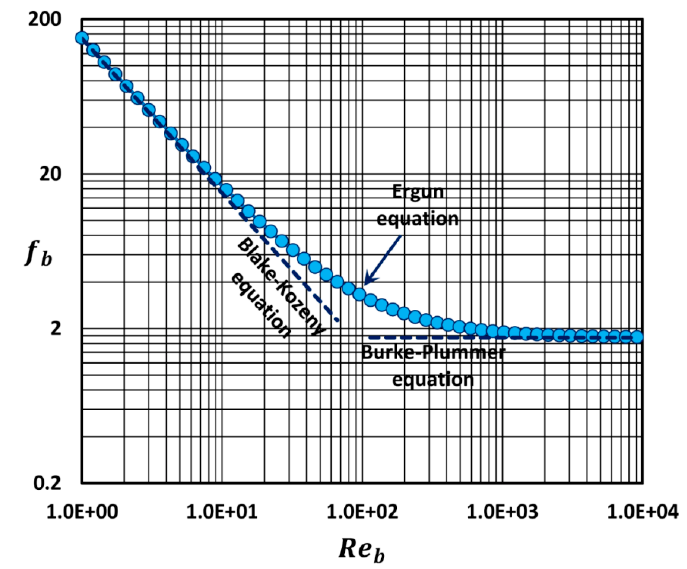
Figure 5. Prediction of packed bed friction factor as a function of packed bed Reynolds number. The data points are generated using the Ergun equation (Equation (37)).